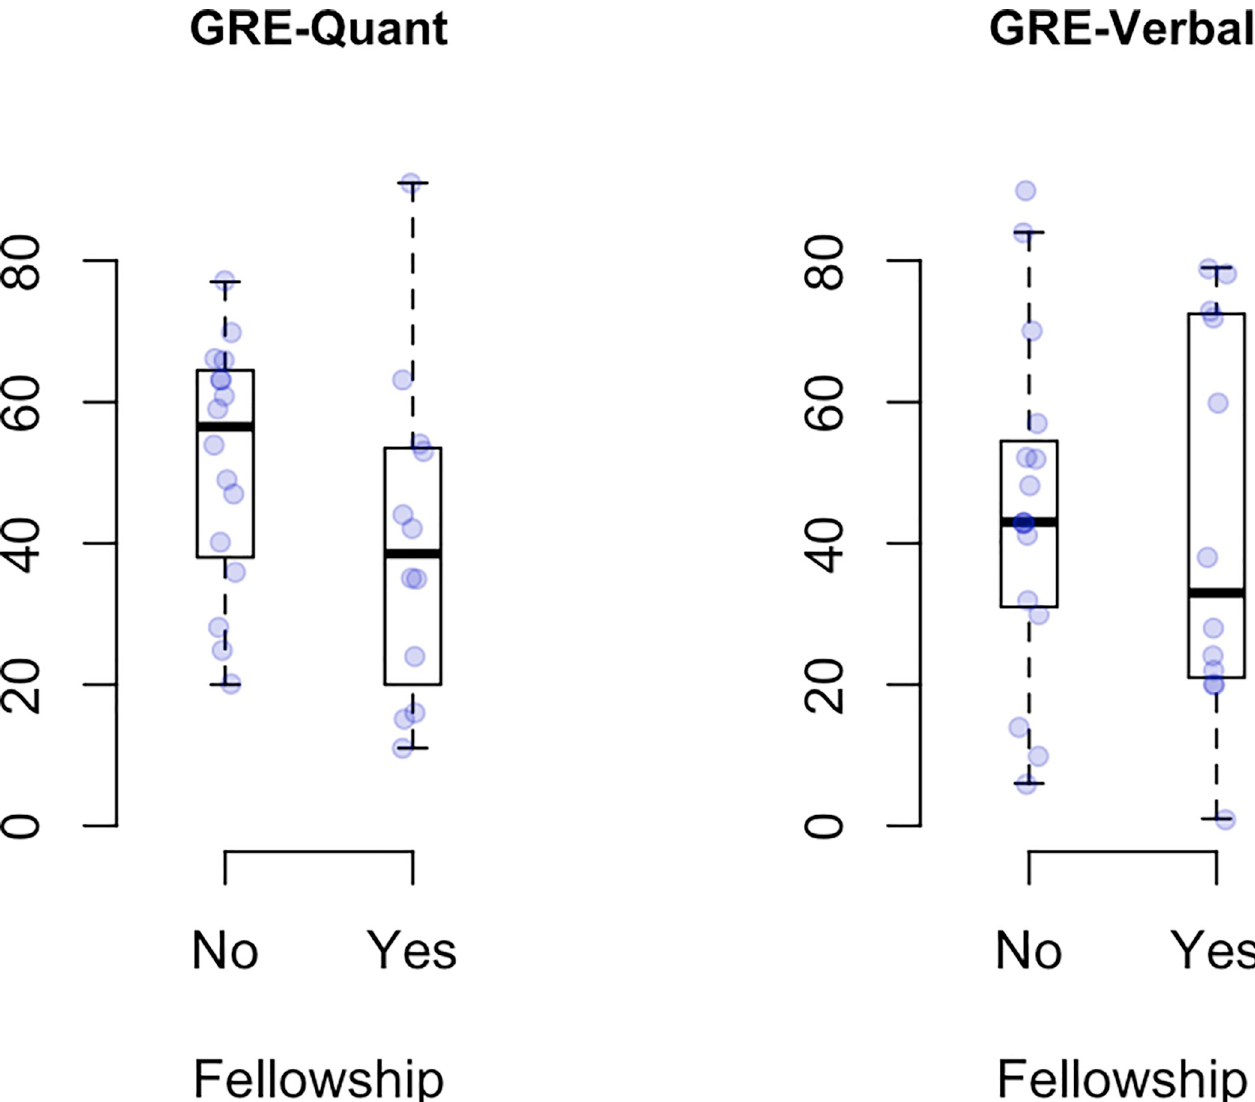
Fig 6. Boxplots of GRE scores stratified by whether or not the students received a fellowship. Data are for fellowships listed in Table 3. The raw data points are overlaid. From bottom to top, the horizontal lines of a boxplot show the minimum GRE score, 25 th percentile, median, 75 th percentile, and max values in a given